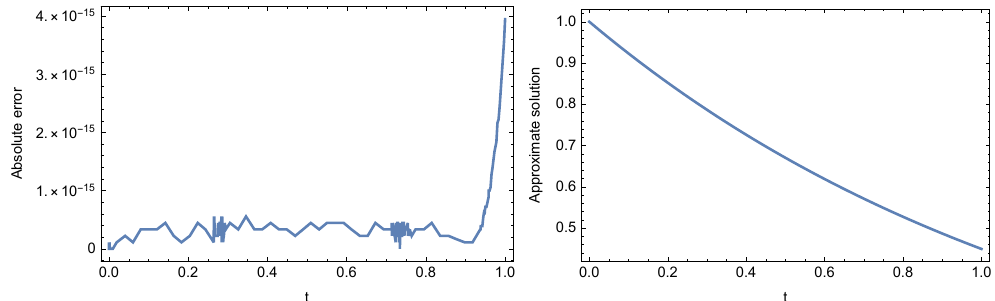
Figure 2. The absolute error ( left ) and approximate solution ( right ) of Example 2.